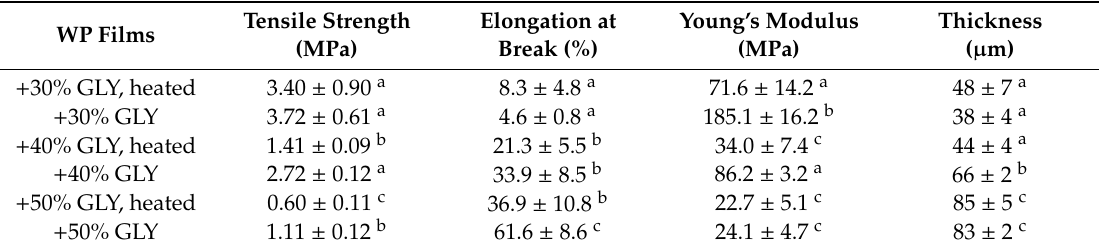
Table 2. Mechanical properties of whey protein (WP) films obtained at pH 12.